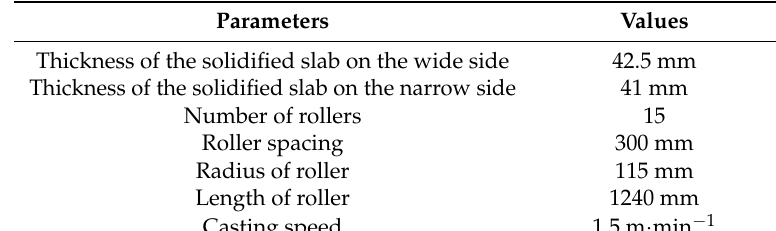
Table 4. Simulation constants for bulge deformations.